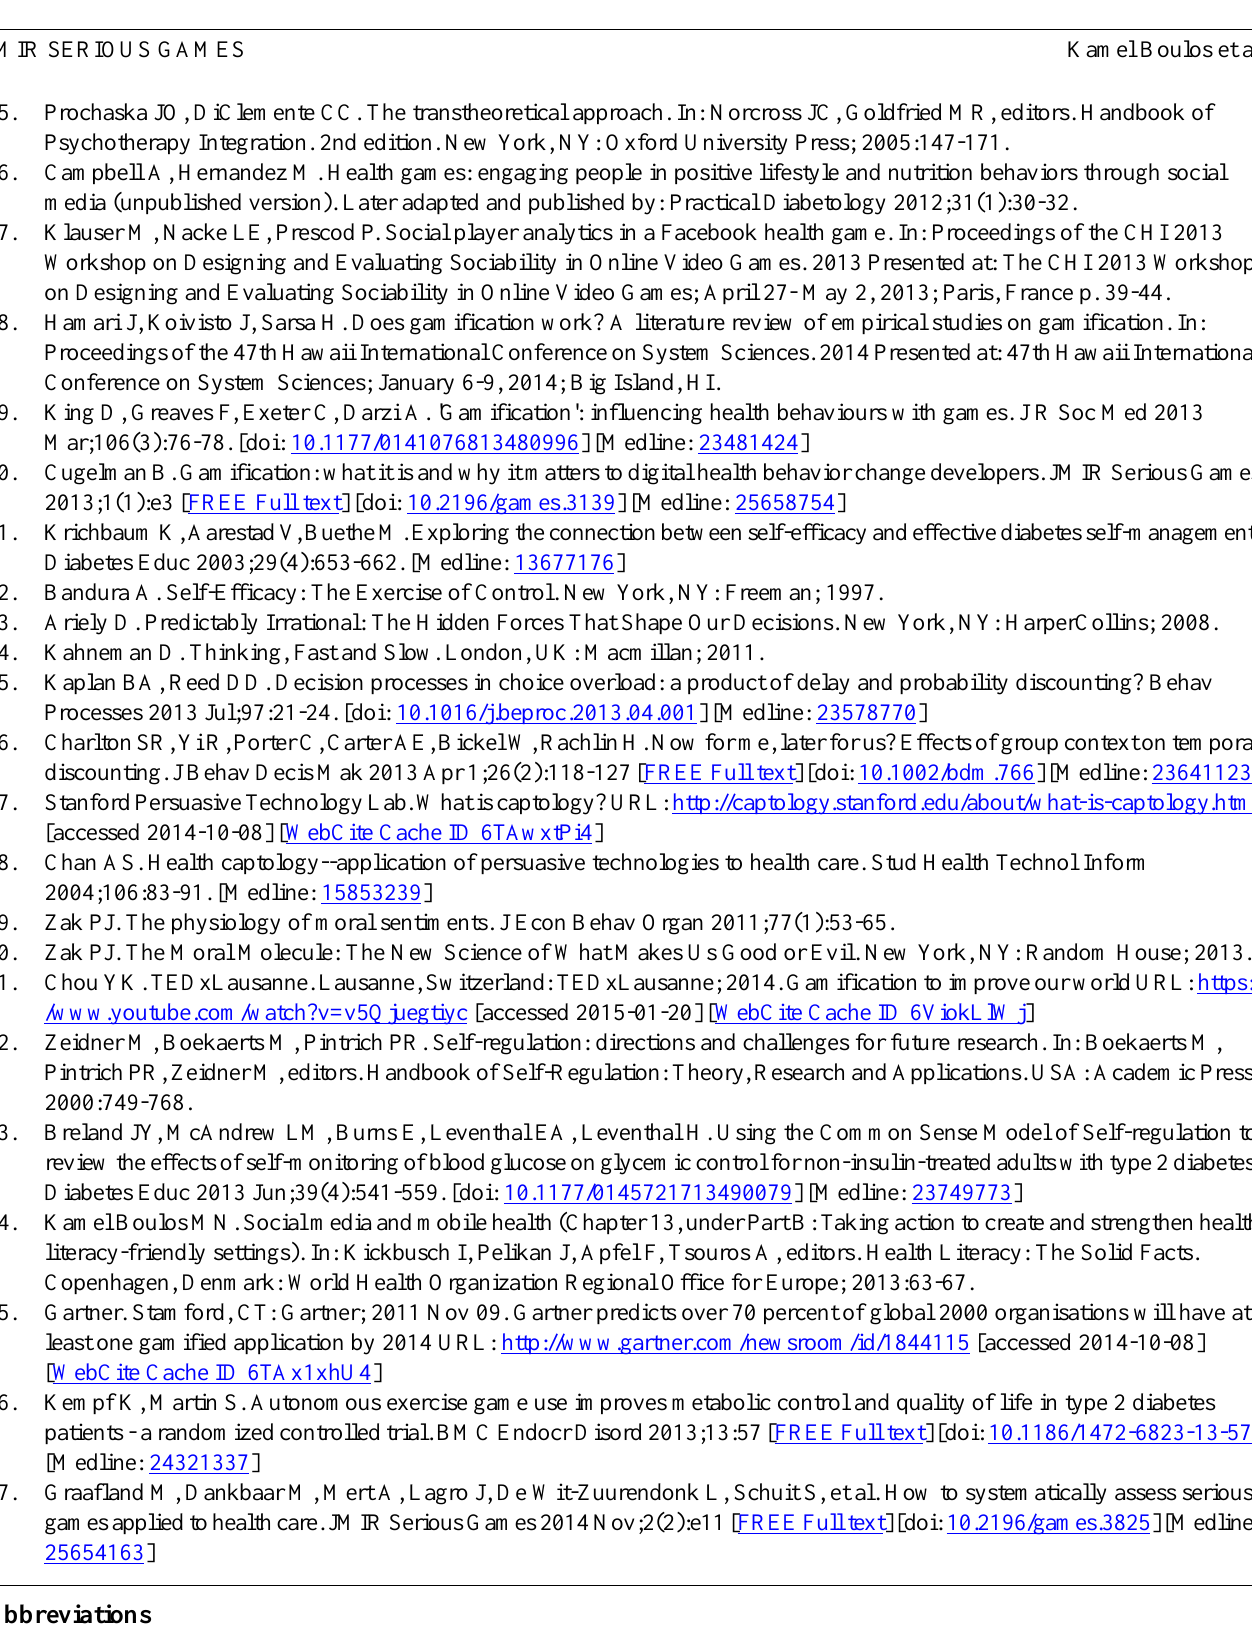
Abbreviations DHF: Diabetes Hands Foundation GPS: global positioning system HOME: human oxytocin-mediated empathy PBL: Points, Badges, and Leaderboards UI: user interface UX: user